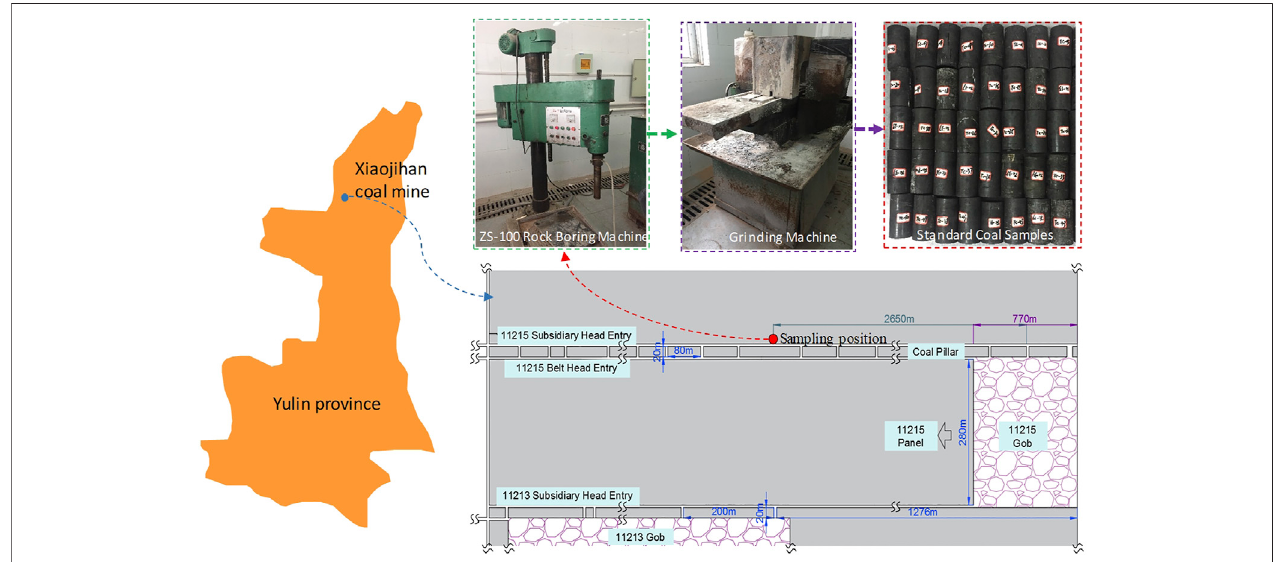
FIGURE1| Corelocationintheminesiteandstandardcoalsampleprocessing(Forinterpretationofthereferencestocolorinthis fi gure,thereaderisreferredtothe web version of this article).